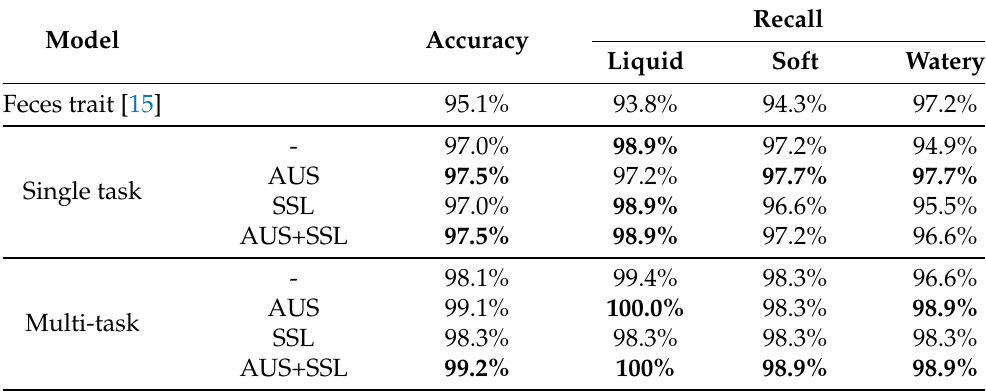
Table 5. Results for three trait categories in medical